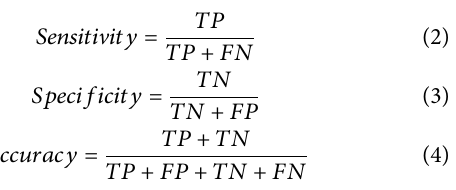
Frontiers in Genetics |